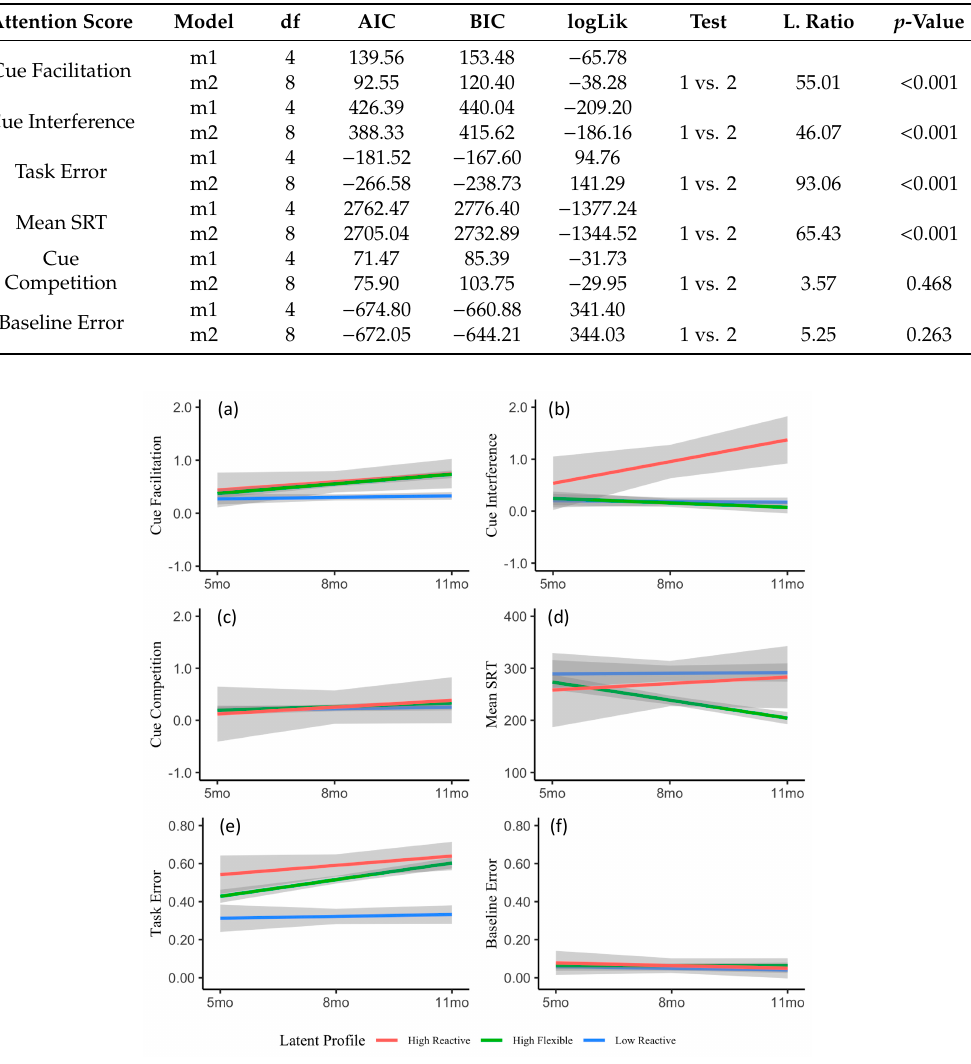
Figure 4. Fitted growth trajectories by age, attention score, and latent profile. Linear mixed-effects (LME) models based on age and phenotype (model 2) accounted for significantly more variance than age-only models (model 1) for four attention scores: Cue facilitation ( a ), cue interference ( b ), mean SRT ( d ), and task error ( e ) all p < 0.001. In contrast, model 2 did not differ from model 1 for either cue competition ( c ) or baseline error (f). Grey shading indicates 95% confidence interval.